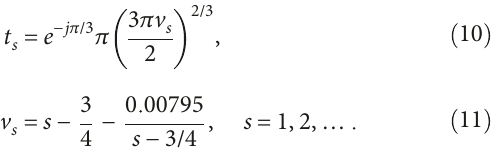
Figure 2: The current moment waveshape (a) in the time domain and (b) in the frequency domain used for computing the lightning VLF radiation at an intermediate distance.